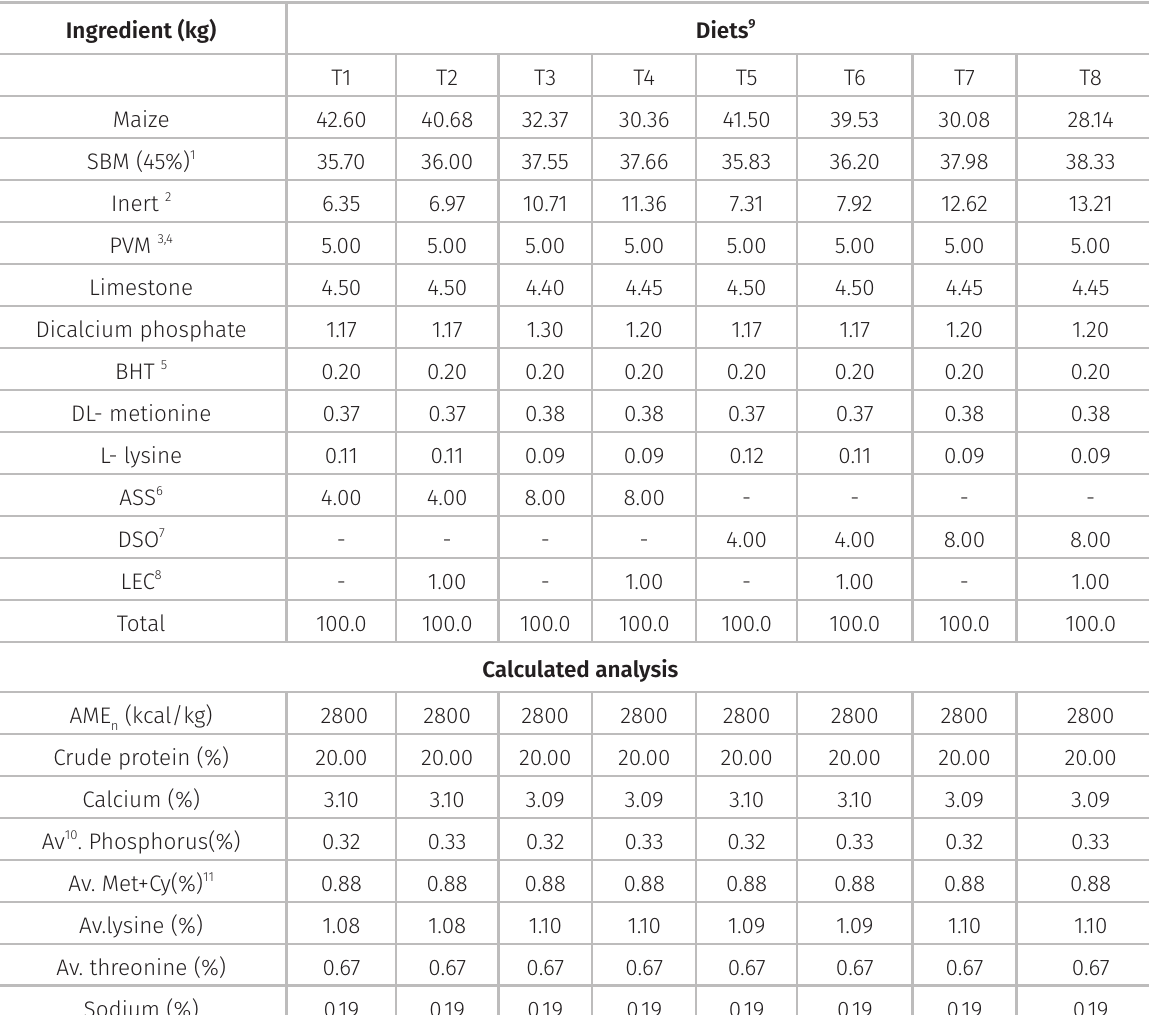
Table I. Ingredient composition and calculated chemical analysis of the experimental diets. Ingredient